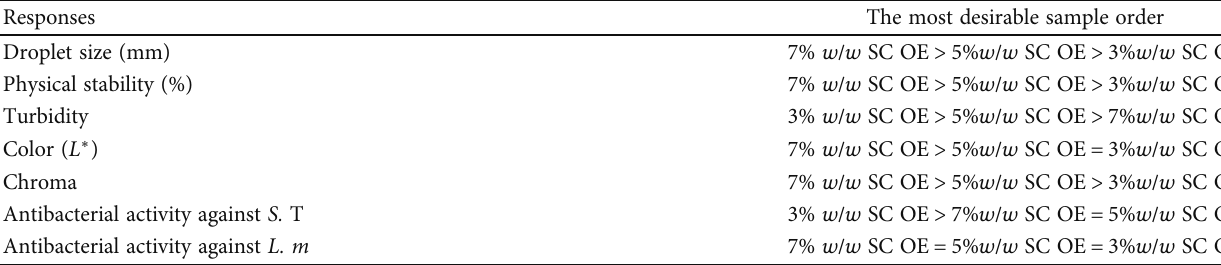
Figure 2. The inhibition zone of the emulsi fi ed onion EO ranged from 12.00 to 7.25 mm. No inhibition zones were produced by a control negative (10% DMSO; emulsions con- tain no EO). As aforementioned earlier, 5% ( w / w ) onion essential oil in free form and streptomycin considered con- trol positive. The lowest zone inhibition diameters for S. Typhimurium and L. monocytogenes belonged to OE, which contained 7% ( w / w ) sodium caseinate at 8.67 and 7.25mm. The highest zone inhibition diameters for S. Typhimurium and L. monocytogenes belonged to OE containing 3% ( w / w ) (12.00 mm) and 5% ( w / w ) (7.25 mm) sodium caseinate, respectively.